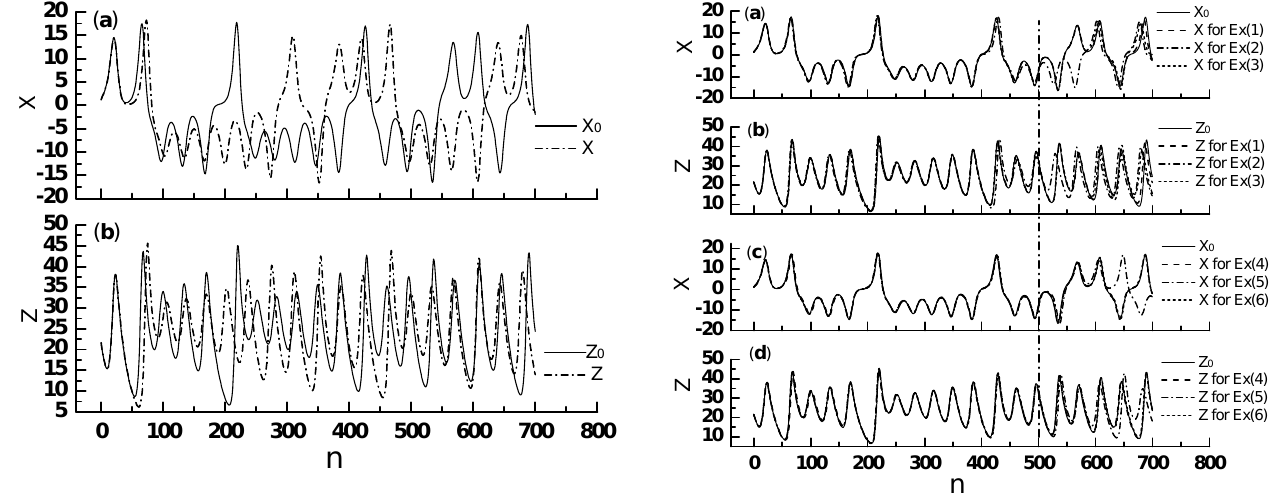
Fig. 3. Error correction based on the first component L x (x,y) using EM. (a) and (b) are the fitting and prediction data of the corrected models using the error function E ( 1 ) x , E ( 2 ) x and E ( 3 ) x , respectively. (c) and (d) are the same as (a) and (b) , but for E ( 4 ) x ,E ( 5 ) x ,E ( 6 ) x ,